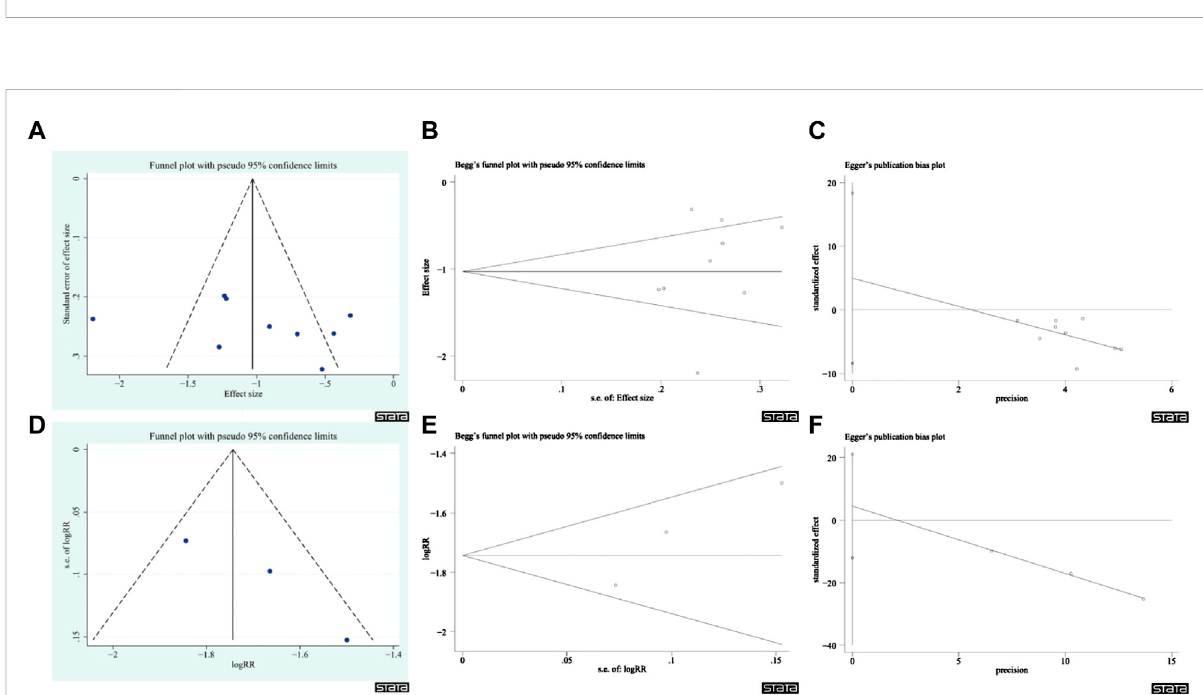
FIGURE 11 Publication bias plots. (A) Funnel plotof CRFTotal continuous variable score. (B) Begg ’ splot ofCRF Total continuousvariable score. (C) Egger ’ s plot of CRF Total continuous variable score. (D) Funnel plot of CRF Total score of Dichotomous data. (E) Begg ’ s plot of CRF Total score of Dichotomous data. (F) Egger ’ s plot of CRF Total score of dichotomous